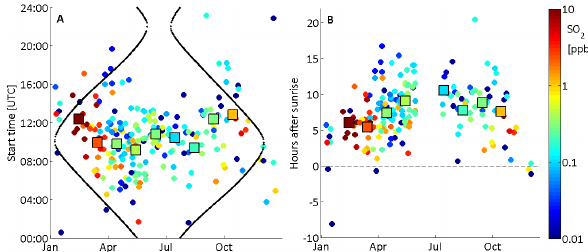
Fig. 3. New particle formation event start times as UTC (A) and Figure 3 New particle formation event start times as UTC (A) and hours after sunrise (B) at 2 hours after sunrise (B) at 1.5nm as a function of SO 2 concentration 1.5 nm as a function of SO 2 concentration (colour scale) for each event separately (circles). 3 (colour scale) for each event separately (circles). The filled rect- The filled rectangles represent the monthly averages for months with at least 10 events. The 4 angles represent the monthly averages for months with at least 10 black curves in (A) denote the sunrise and –set times, respectively. 5 events. The black curves in (A) denote the sunrise and sunset times,